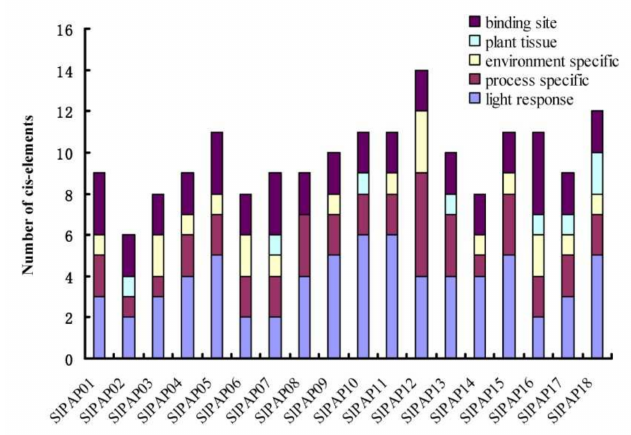
Figure 4. Cis-elements in the promoters of putative SlPAP genes that are related to stress responses. Different cis-elements with the same or similar functions are present with the same color.